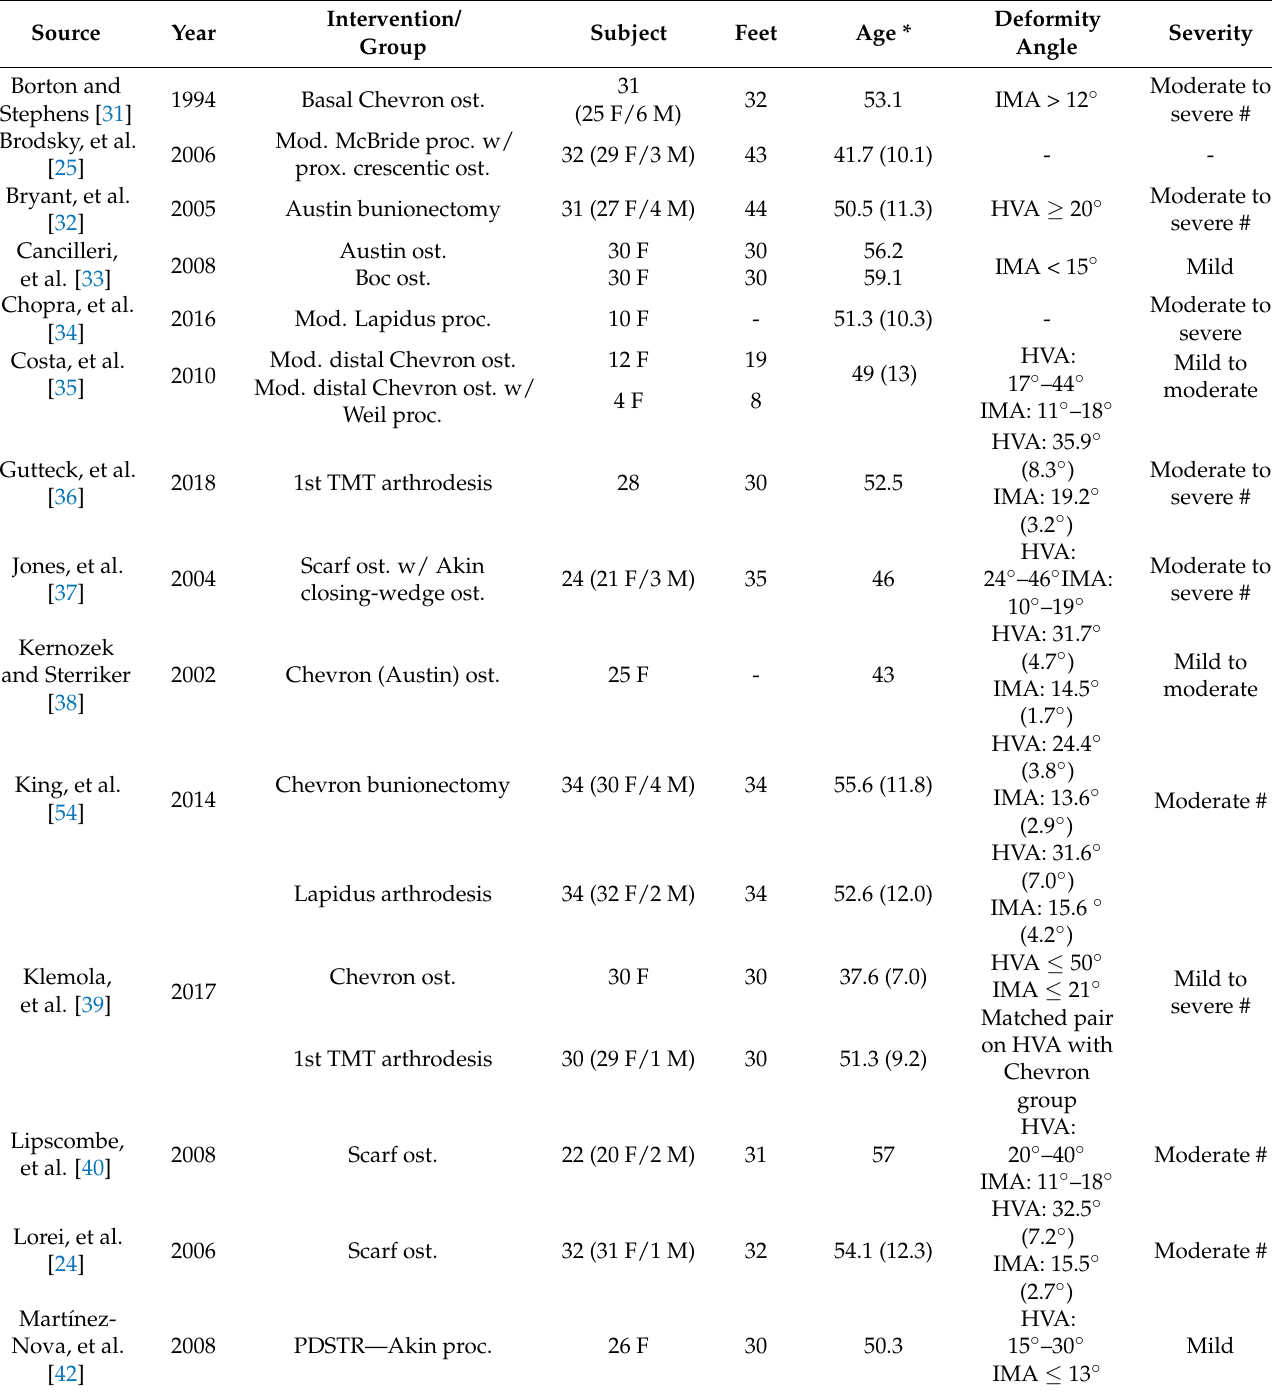
Table 1. Patient information of the reviewed